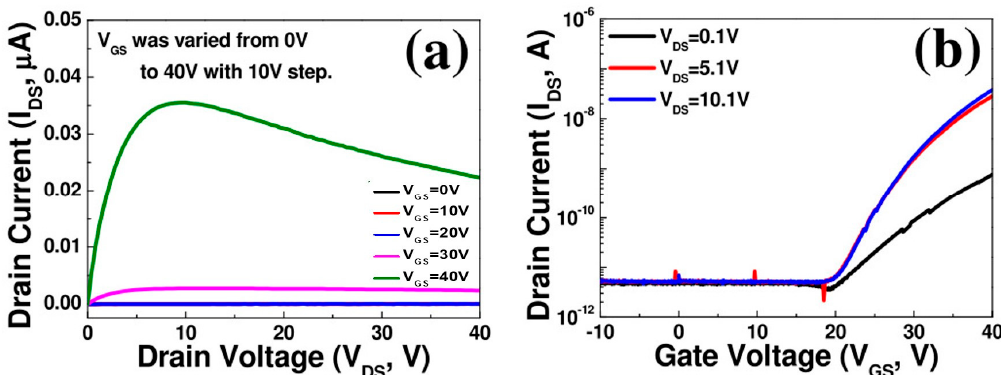
Figure 4. ( a ) Output characteristics and ( b ) transfer characteristics of the a-IGZO TFT thermally annealed at 200 ◦ C. The current-decreasing phenomena originates from defective states that can obstruct the current flow.